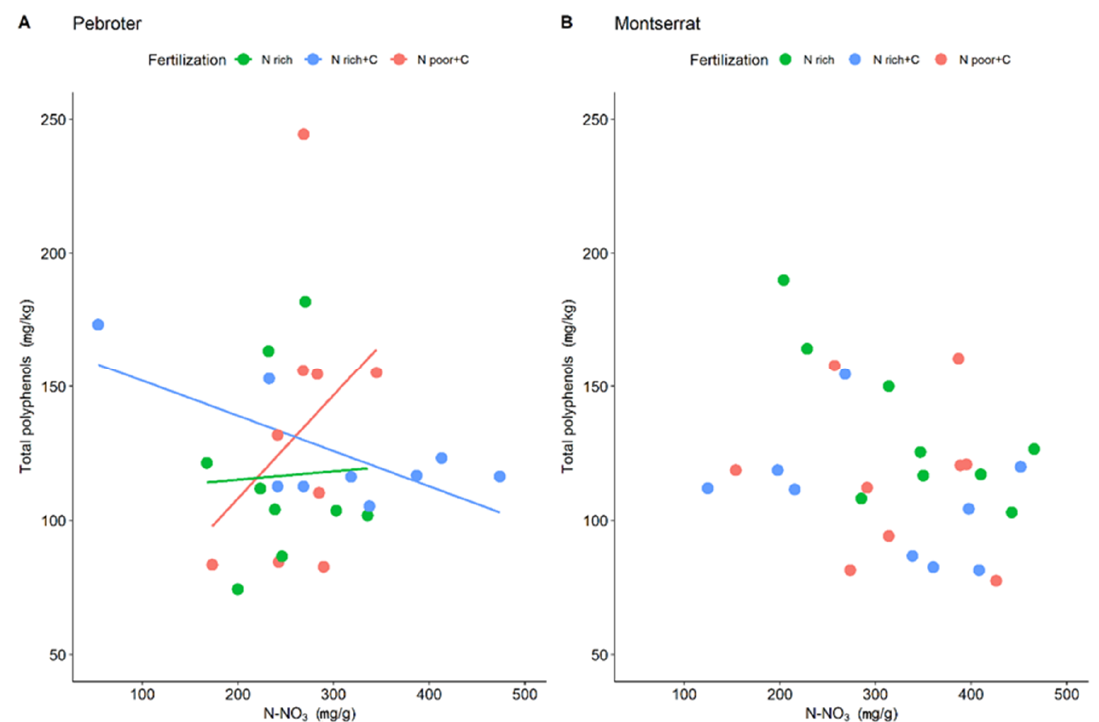
Figure 5. Effect of fertilization and nitrates (N-NO 3 ) on total phenolic content in Pebroter ( A ) and Montserrat ( B ) varietal groups.